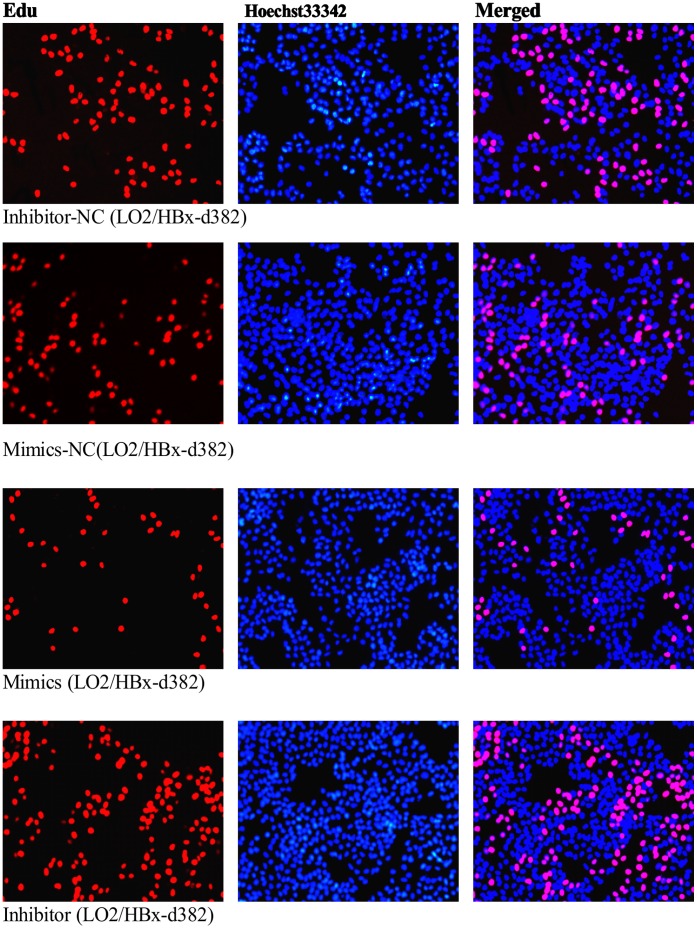
miR-338-3p inhibits cell proliferation by Edu assay.(A–B) Representative profiles of Edu cell proliferation after transfection with miR-338-3p mimics or inhibitor in LO2/HBx-d382 and LO2/HBx cells compared to their negative control transfection (magnification 100×). (C) Rate of Edu positive cells in S phase. Gain of miR-338-3p inhibits the cellular DNA replication in HBx-expressed LO2 cells and control cells, whereas loss of miR-338-3p expression demonstrates an adverse result, especially in LO2/HBx-d382 cells. (*P<0.001; **P<0.01; ***P<0.05).